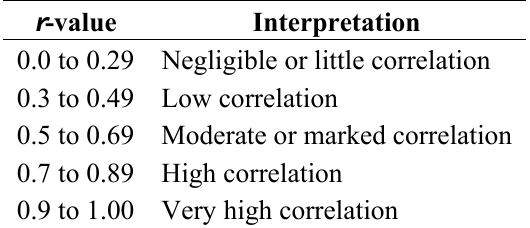
Table 1. Guildford’s rule of thumb for interpreting correlation coefficient